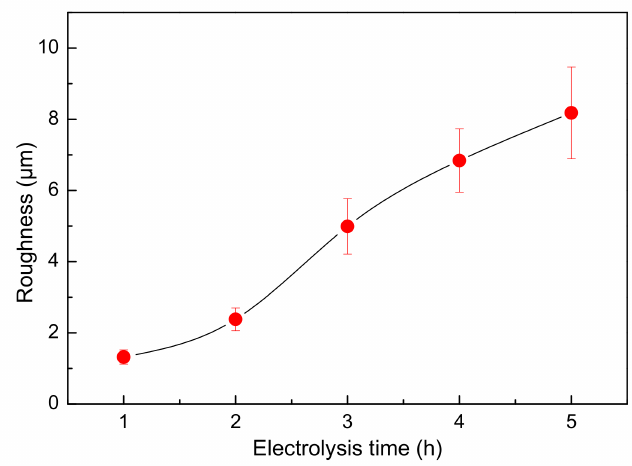
Figure 3. Effect of electrolysis time on the surface roughness of cathode copper in the conventional inlet mode. Bars represent standard deviation. The electrolyte circulation rate was 1.0 L · min − 1 .